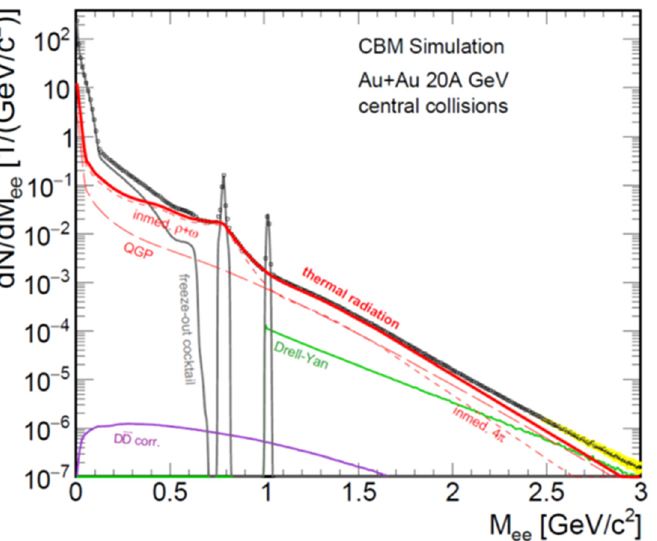
Figure 8. Di-electron invariant mass spectrum simulated for central Au + Au collisions at 20 A·GeV [5].